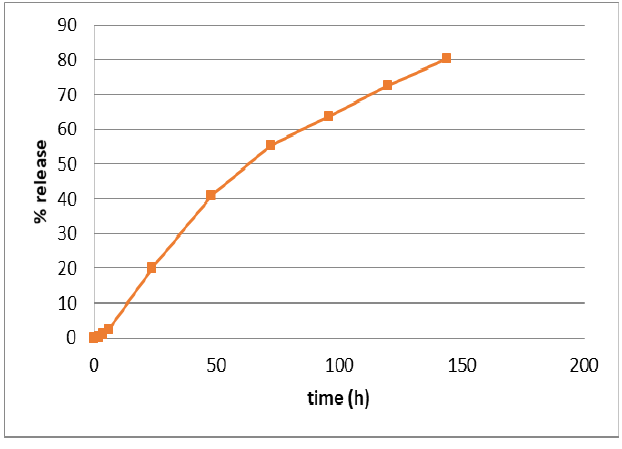
Fig. 2. releasing pattern of the doxycycline